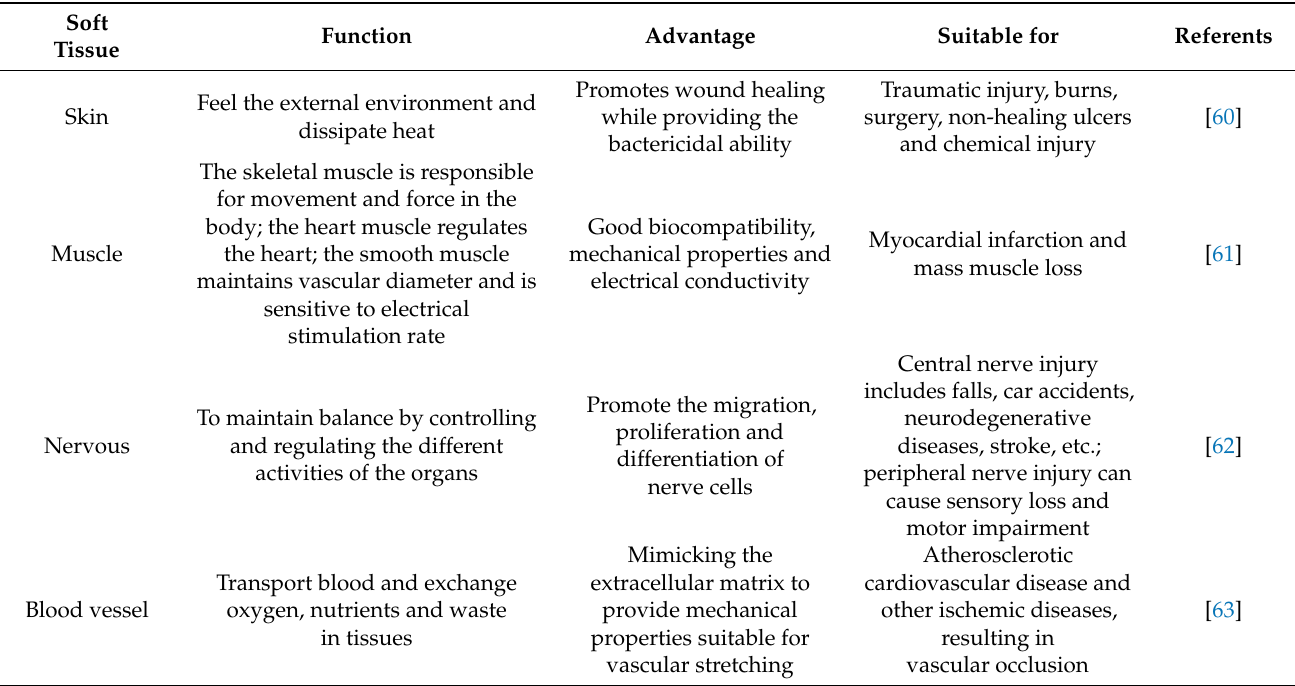
Table 1. Summary of GBNs for soft tissue